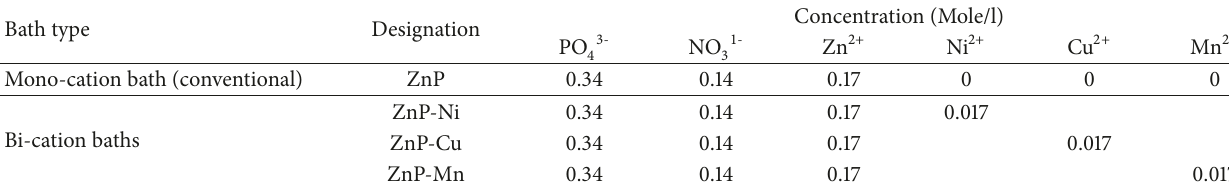
Figure 2: (a) Photograph of the some phosphated steel rebars; (b) an optical microscopy photo of cross-sectional ZnP-Ni treated steel. Table 1: Chemical composition of the prepared zinc phosphating baths.